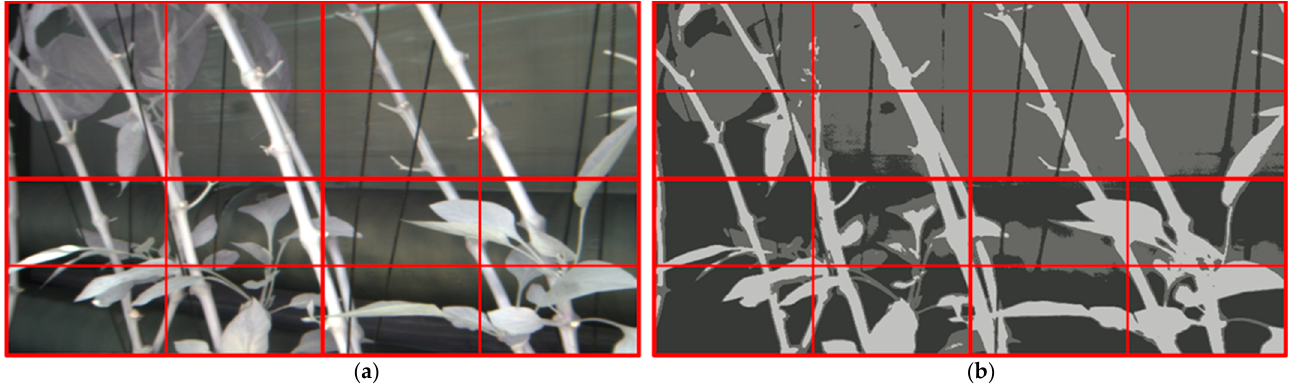
Figure 8. Pictures of each part before image segmentation ( a ) and after image segmentation ( b ).